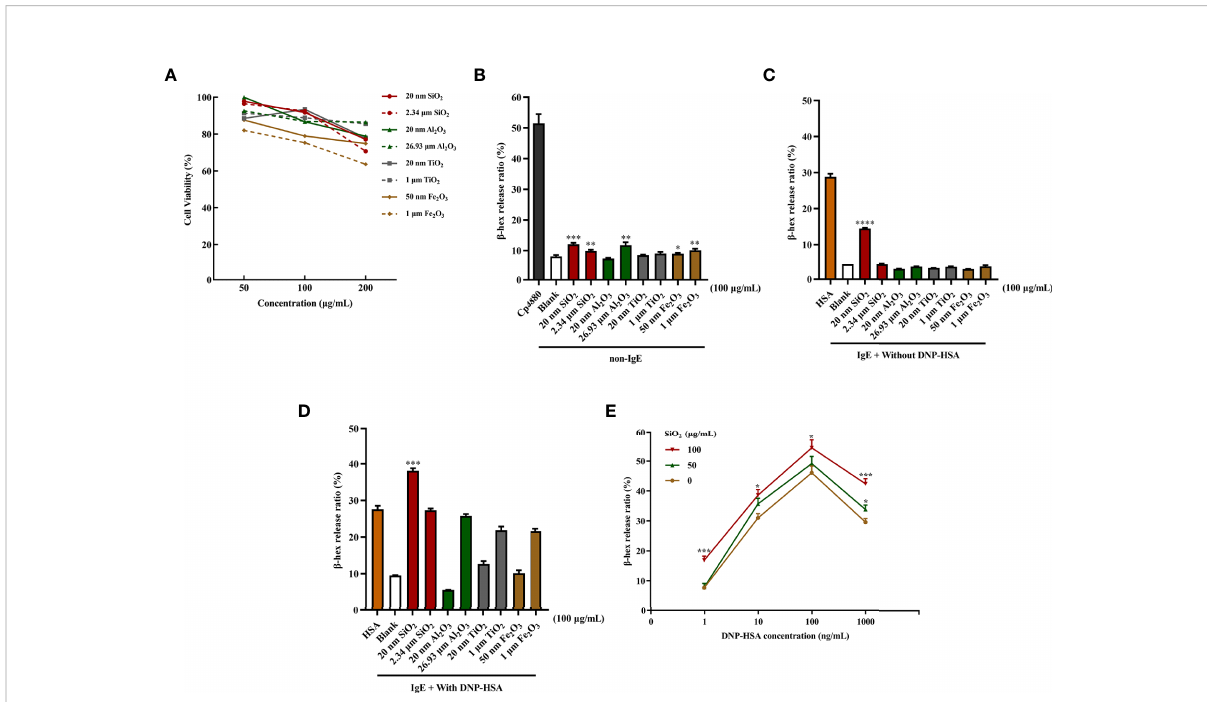
FIGURE 1 Particle exposure induced cytotoxicity and degranulation of mast cells. (A) Cytotoxicity of particle exposure on mast cells. (B) Non-IgE pathway- mediated mast cell activation. BMMCs were not sensitized with anti-DNP IgE and directly treated with particles of different sizes. Compound 48/ 80 was used as the positive control. The comparator was the blank control. (C) BMMCs were sensitized with anti-DNP IgE before treatment with different particle sizes but without DNP-HSA stimulation. DNP-HSA stimulation was used as the positive control. The comparator was the blank control. (D) IgE-mediated mast cell degranulation. BMMCs were sensitized with anti-DNP IgE before treatment with particles of different sizes and stimulated with DNP-HSA. The comparator was the DNP-HSA stimulation group. (E) Effects of different doses of 20 nm SiO 2 exposure on Fc ϵ RI-mediated mast cell degranulation. All data are presented as the mean ± SD. The unpaired t test or ordinary one-way ANOVA was used to compare different groups. * P < 0.05, ** P < 0.01, *** P < 0.001, **** P <